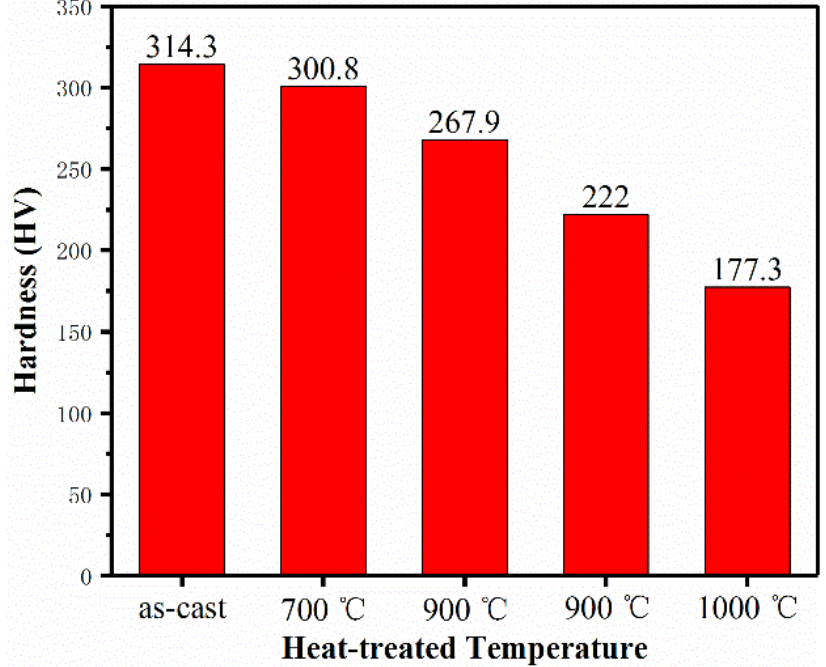
Figure 5. Micro-hardness of FeCrMnNi alloy at different heat treatment temperatures.